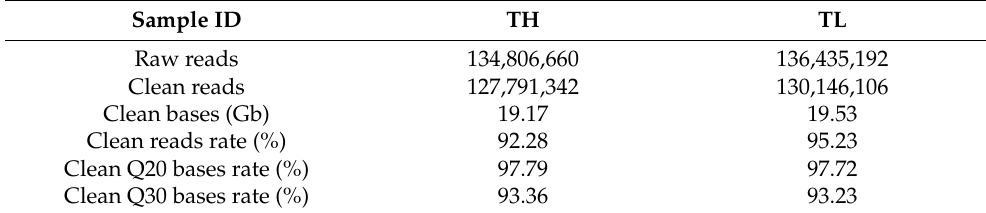
Table 1. Summary information of the D. loddigesii RNA-seq data.